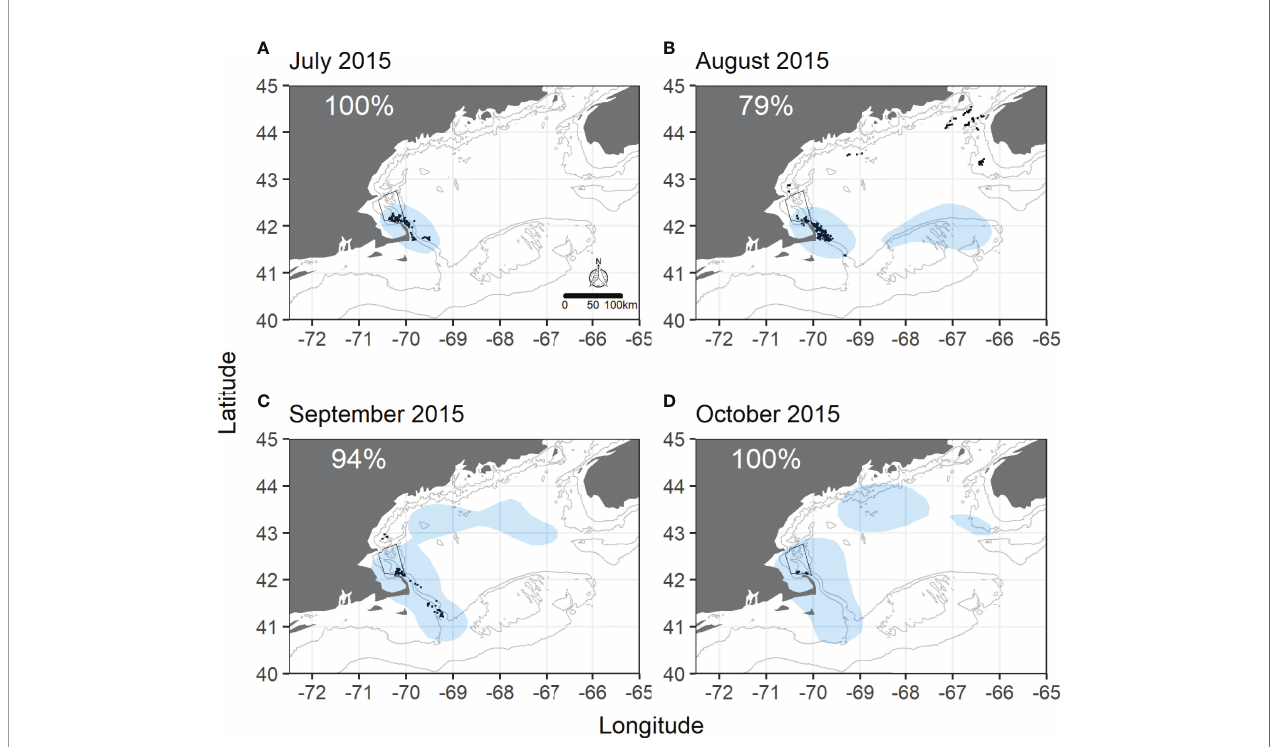
FIGURE 2 | Monthly overlap between great shearwaters and humpback whales at the Gulf of Maine scale in 2015. (A) July 2015, (B) August 2015, (C) September 2015, (D) October 2015. Shaded blue areas are shearwater utilization distributions (GOM-wide) from 50% kernel density isopleths. Black dots are daily, unique sightings of individually identi fi ed humpback whales recorded during GOM-wide humpback whale surveys. SBNMS boundaries are in black. Gray lines represent 50m and 100m depth contours. Percentages represent the percentage of humpback whale sightings falling within the shearwater